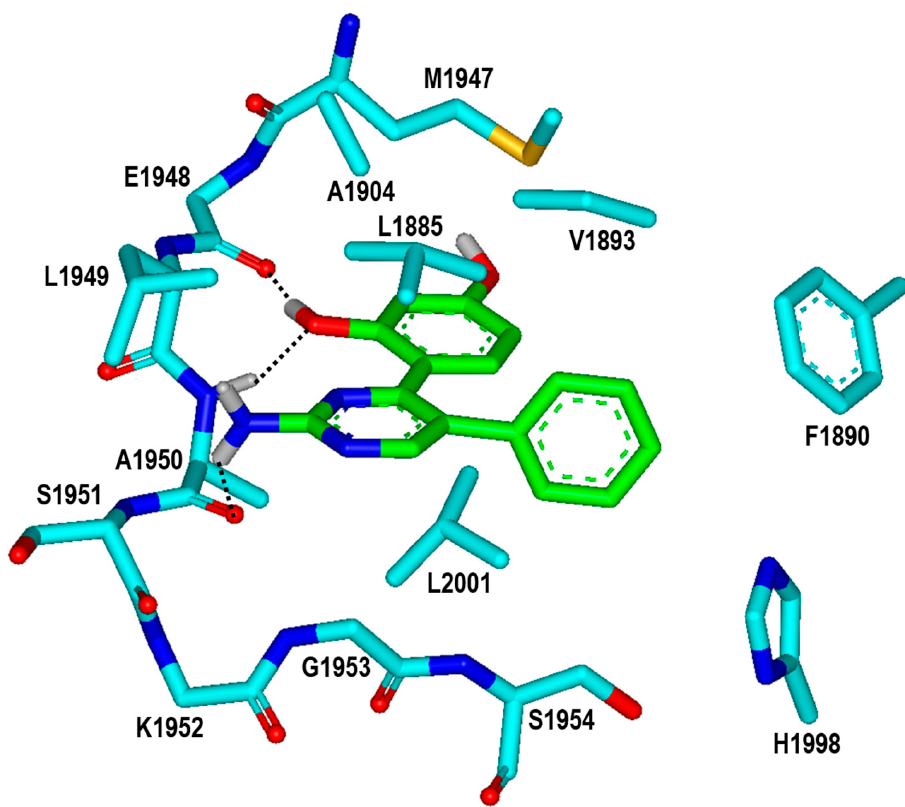
Figure 7. Calculated binding mode of Inhibitor 2 in the ATP-binding site of the G2019S mutant of LRRK2. The carbon atoms of the G2019S mutant and Inhibitor 2 are colored in cyan and green, respectively. Each dotted line indicates a hydrogen bond.